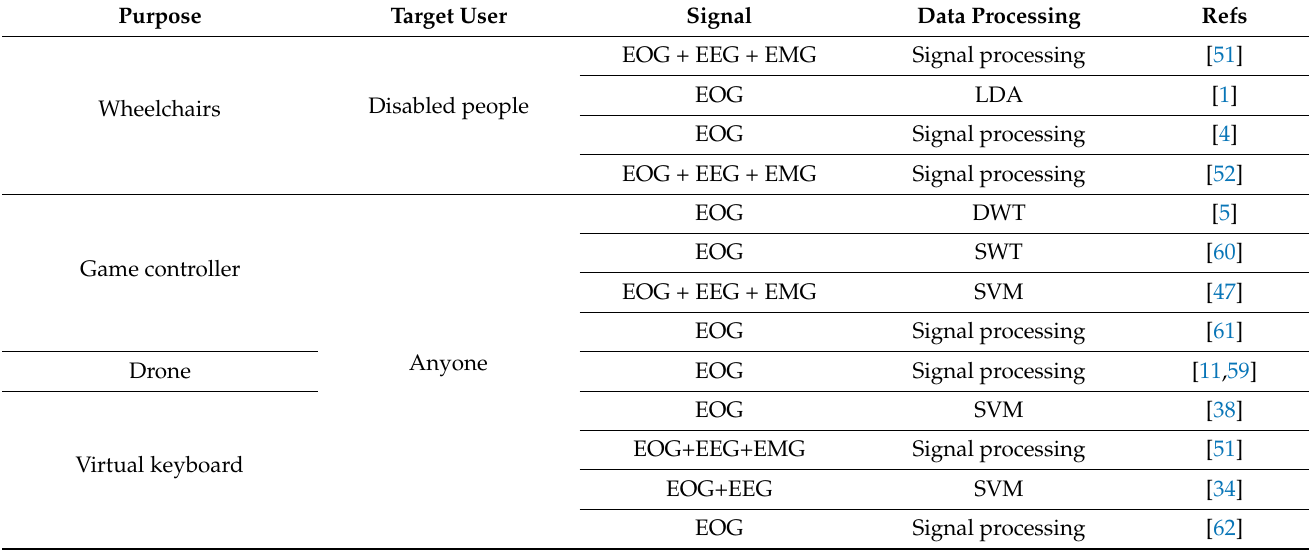
Table 3. Summary of applications using EOG